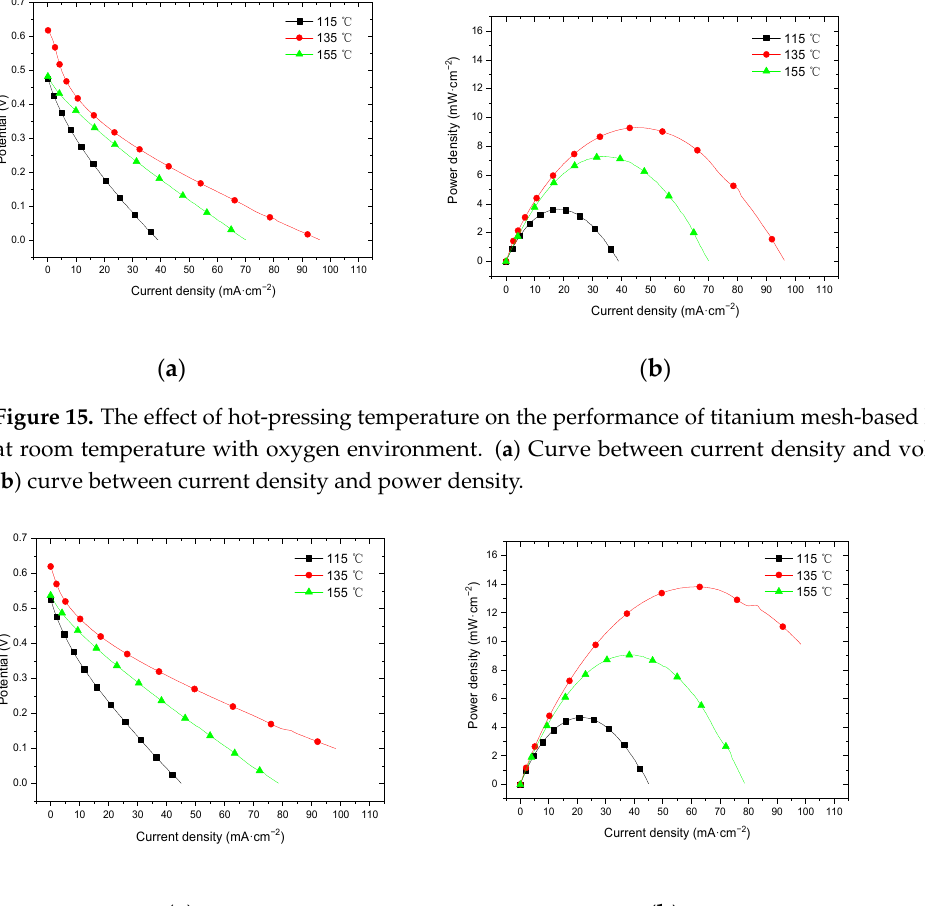
Figure 16. The effect of hot-pressing temperature on the performance of titanium mesh-based MEA